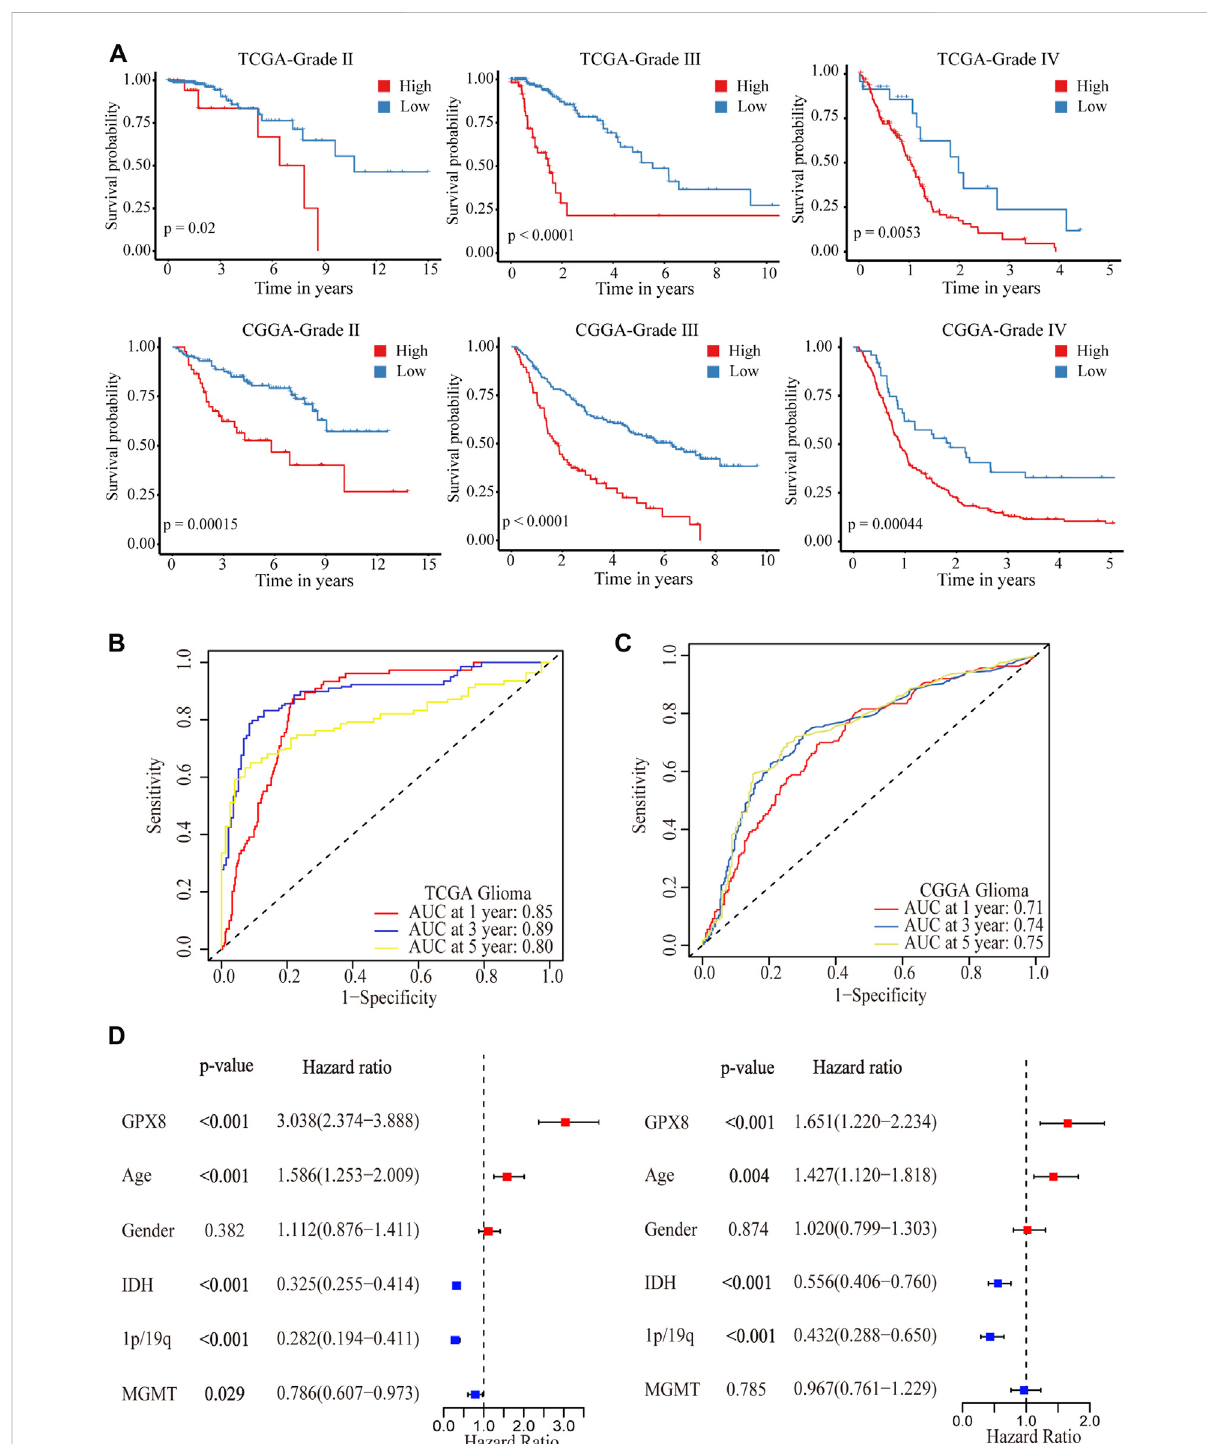
FIGURE 3 Correlation analysis between GPX8 and prognosis of glioma patients. (A) Kaplan – Meier overall survival plot showing survival rates for all WHO- grade glioma patients with GPX8 low expression (blue), and high expression (red) in TCGA and CGGA datasets. (B,C) Time-dependent ROC analysis showing the prognostic ef fi cacy of GPX8 for glioma patients in TCGA and CGGA datasets. (D) Forest plot for univariate and multivariate Cox analysis of CGGA